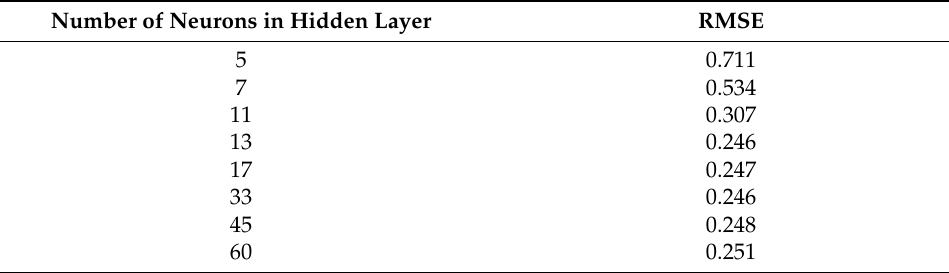
Figure 2. Structure of ANN for prediction of Table 2. RMSE values for various ANNs with different structures. Number of Neurons in Hidden